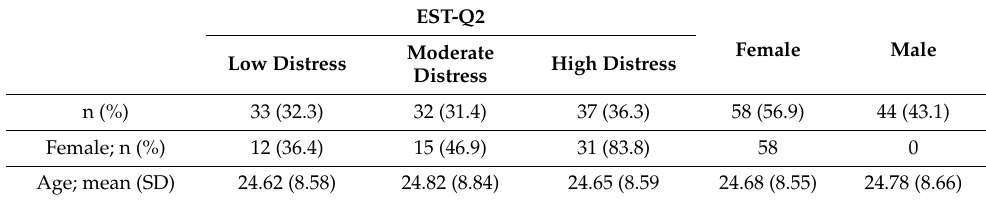
Table 1. The age and gender in different EST-Q2 groups.